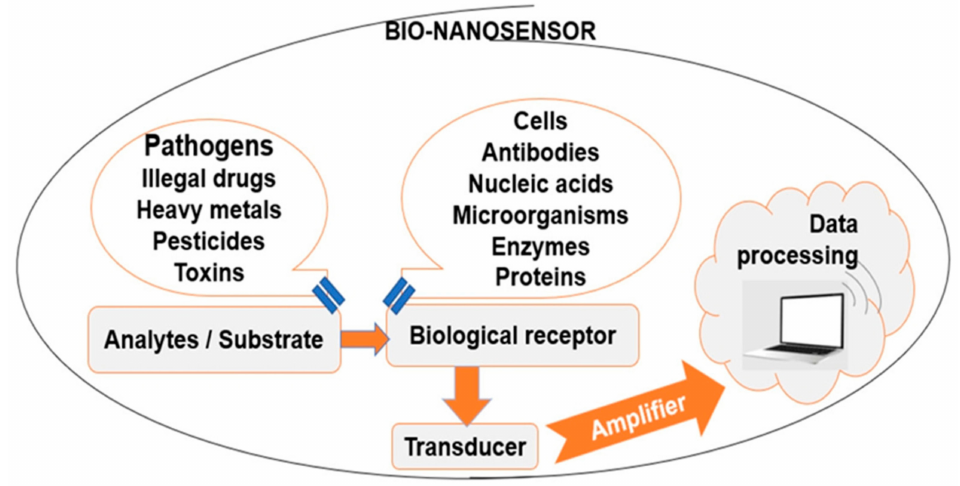
Figure 3. Typical bio-nanosensor components.